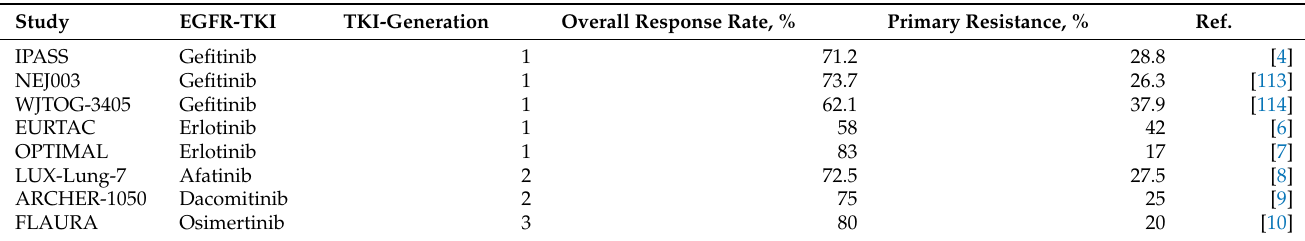
Table 2. The rate of primary resistance in key clinical